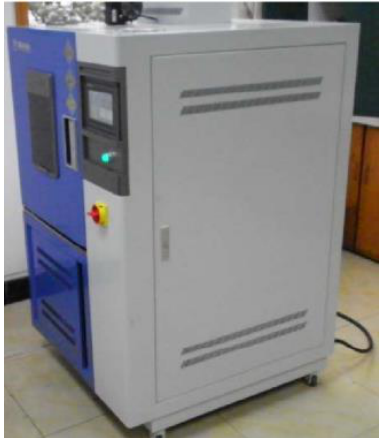
Figure 1. RG-80 asphalt aging test chamber.